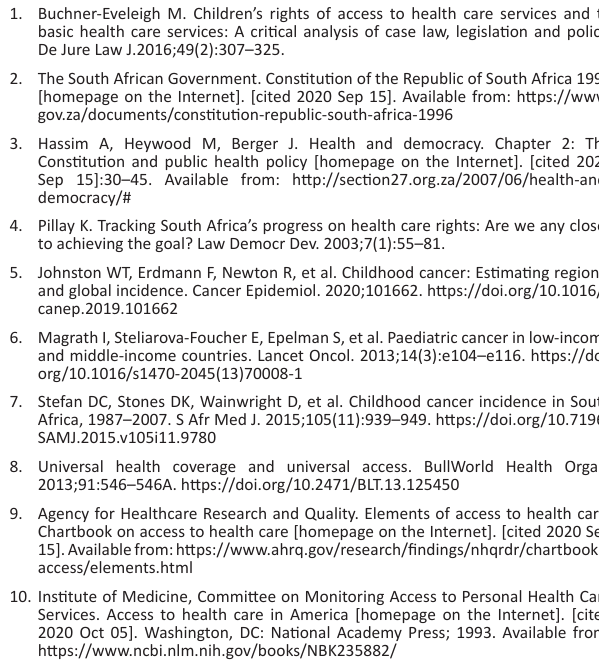
table for academic purposes from Parikh et al. Clinical Practice Guidelines: SIOP-PODC Adapted Risk Stratification and Treatment Guidelines: Recommendations for